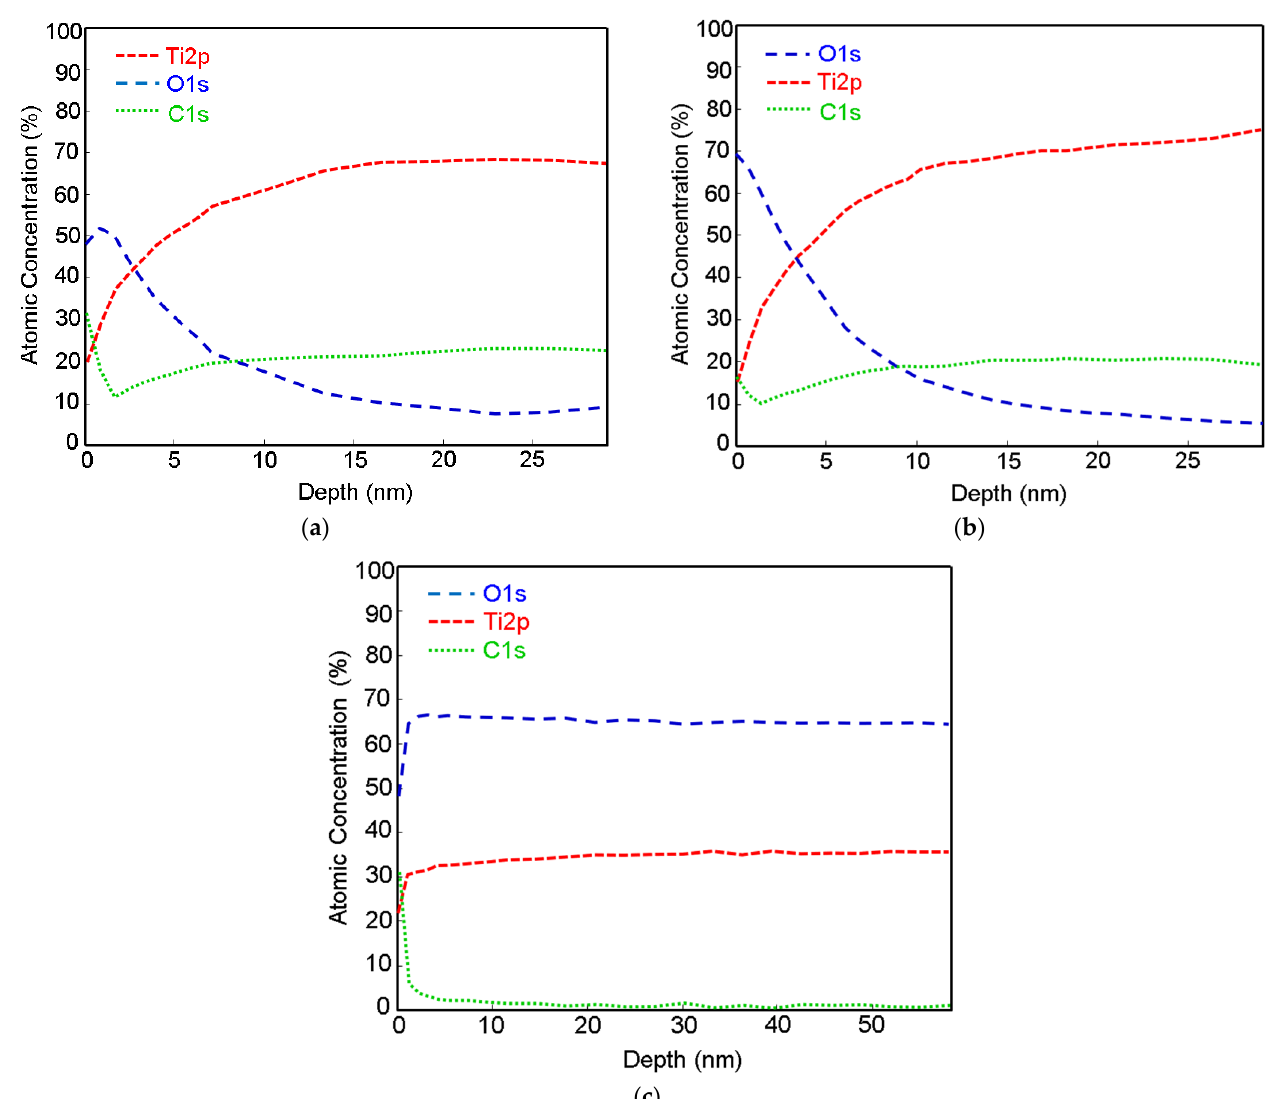
Figure 2. XPS depth profile analysis of the ( a ) untreated Ti substrate (Ti), ( b ) plasma-treated Ti substrate (Ti + P) and ( c ) hydrothermally treated Ti substrate (Ti HT).